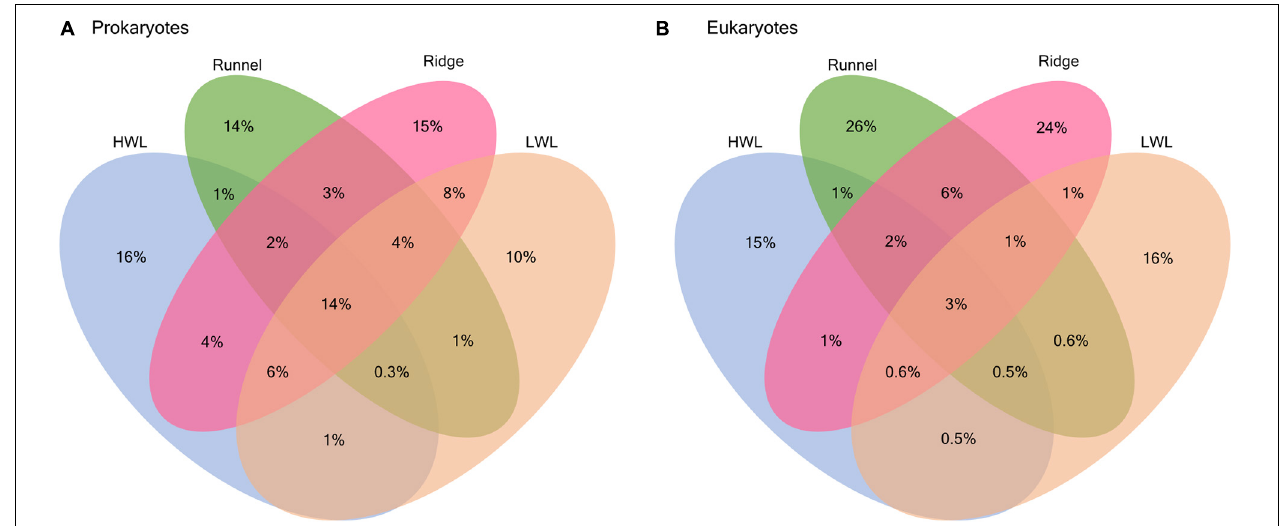
FIGURE 2 | Venn diagrams showing the percentage of shared ASVs between different stations for (A) prokaryotic and (B) eukaryotic communities.